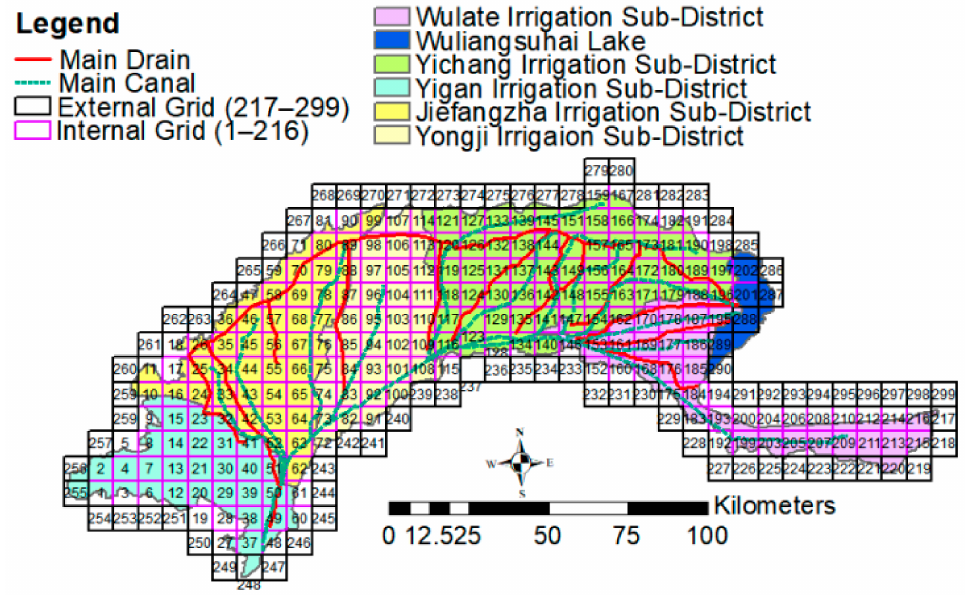
Figure 4. Nodal network polygonal configuration of the SAHYSMOD